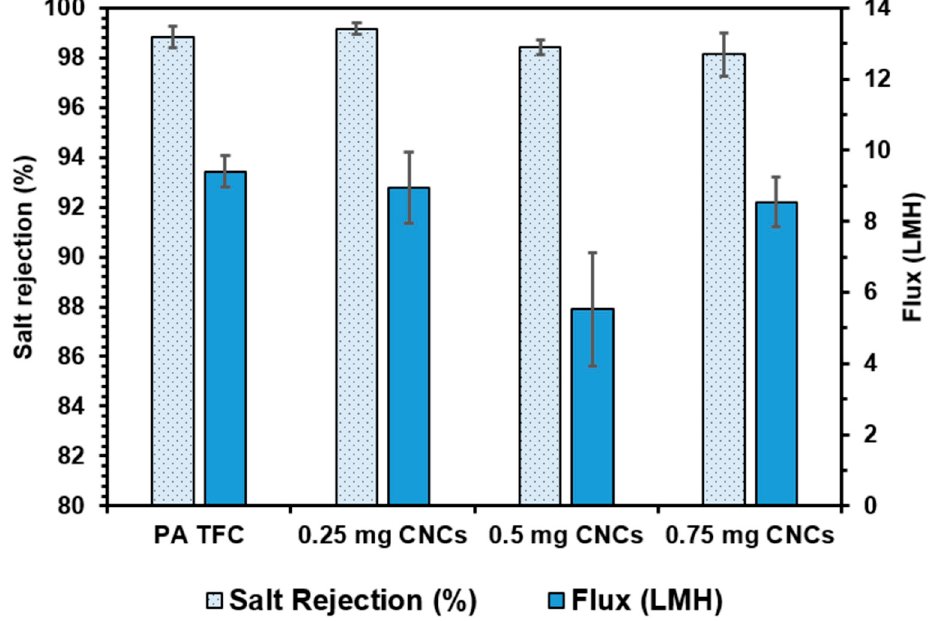
Figure 10. Flux and salt rejection results for CNC containing TFN membranes fabricated using the vacuum filtration method.